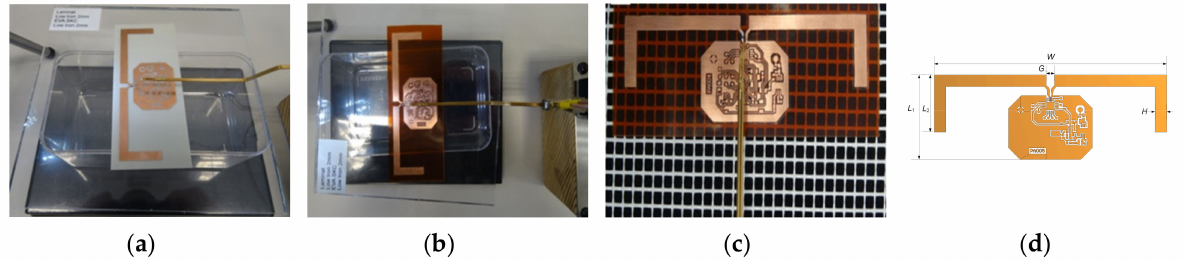
Figure 3. Measurements of RFID antennas: ( a ) PCB substrate on low-iron laminate; ( b ) Flexible substrate in free space, plastic net under the sample; ( c ) Flexible substrate on low-iron laminate; ( d ) Numerical model ( L x , W x , H , G